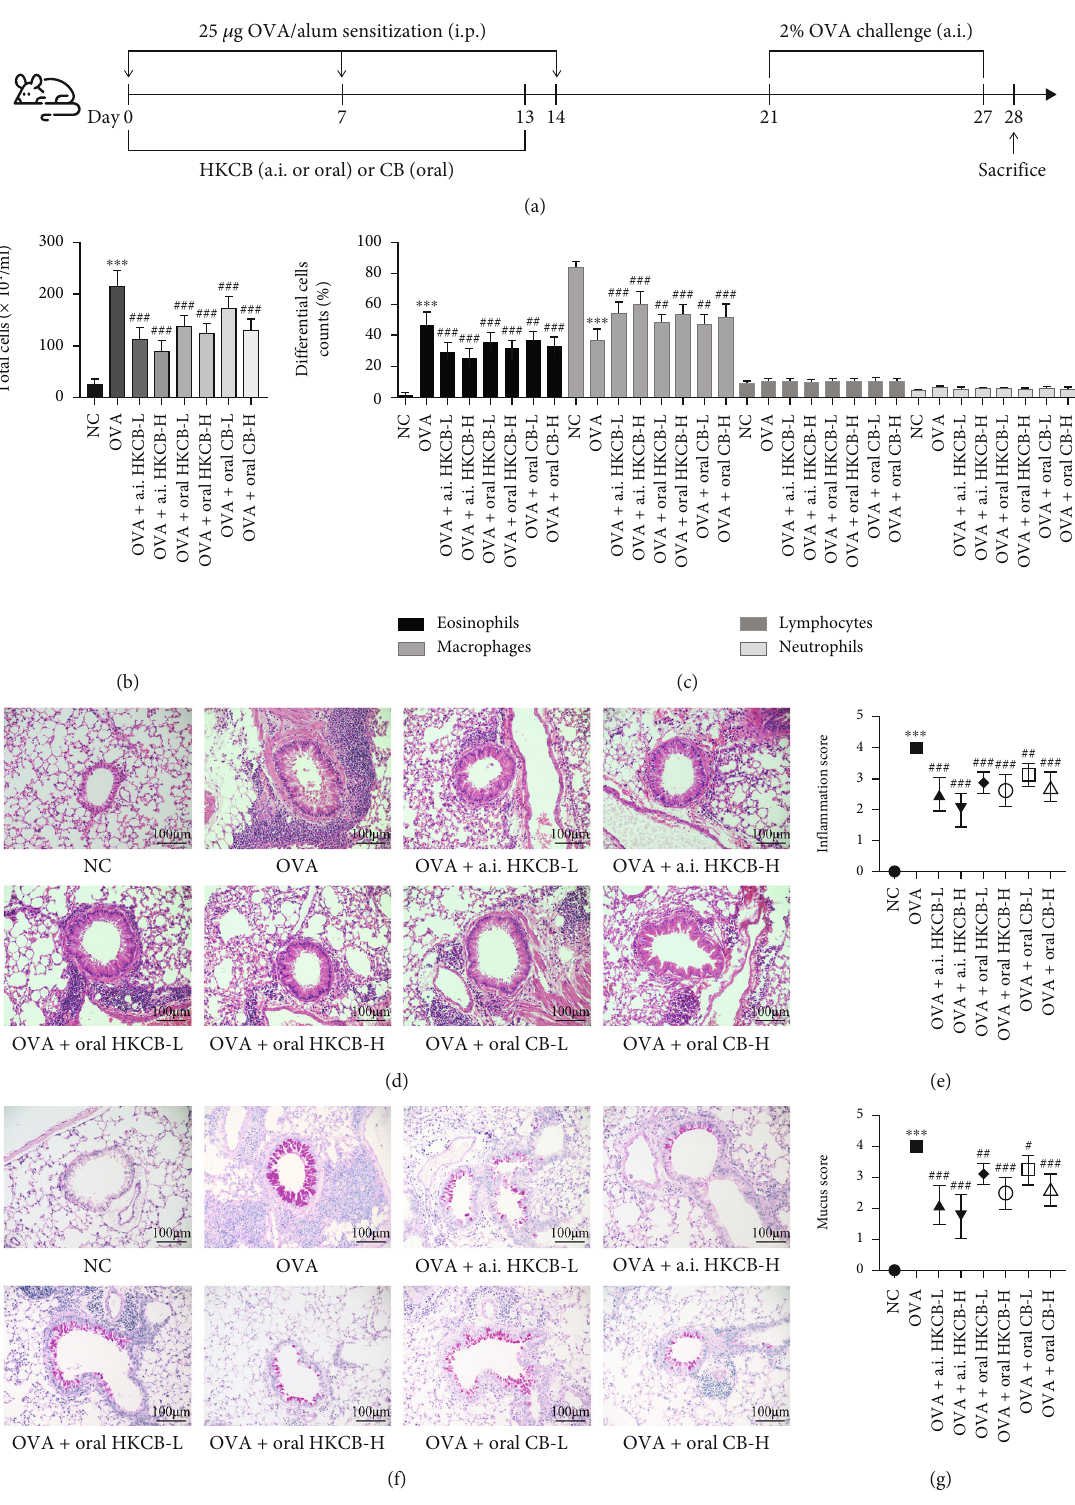
Figure 1: Aerosol inhalation of HKCB, oral HKCB administration, or oral CB administration alleviated allergic airway in fl ammation and mucus hypersecretion. (a) Experimental protocol. (b) Total in fl ammatory cell count in the BALF. (c) The percentages of di ff erential in fl ammatory cells in the BALF. (d) HE staining of the lung tissues (magni fi cation 200x). (e) In fl ammation scores. (f) PAS staining of the lung tissues (magni fi cation 200x). (g) Mucus scores. ∗∗∗ P < 0 : 001 versus the NC group; # P < 0 : 05 , ## P < 0 : 01 , and ### P < 0 : 001 versus the OVA group. i.p.: intraperitoneally; a.i.: aerosol inhalation; CB: Clostridium butyricum ; HKCB: heat-killed CB; HE: hematoxylin-eosin; PAS: periodic acid-Schi ff ; BALF: bronchoalveolar lavage fl